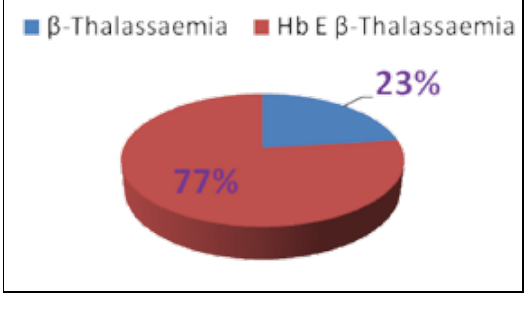
Fig 1. Type of thalassaemia patients (n=320)